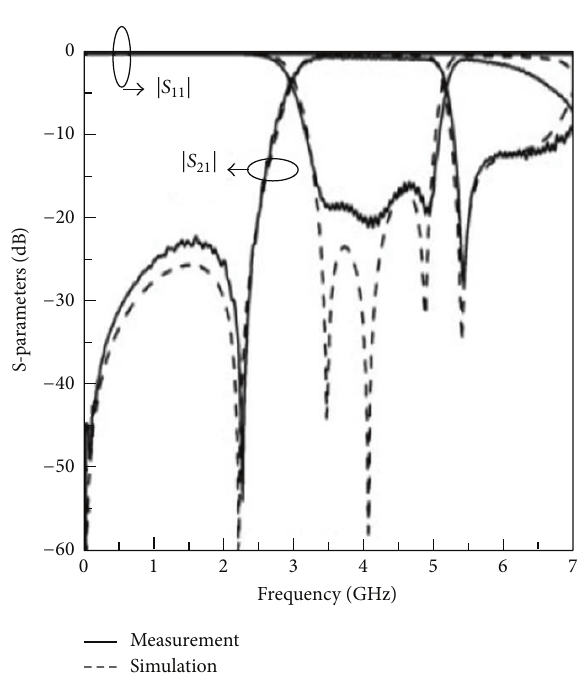
Figure 14: Comparison between the simulated and measured frequency response of the band-pass filter designed using the given asymmetric